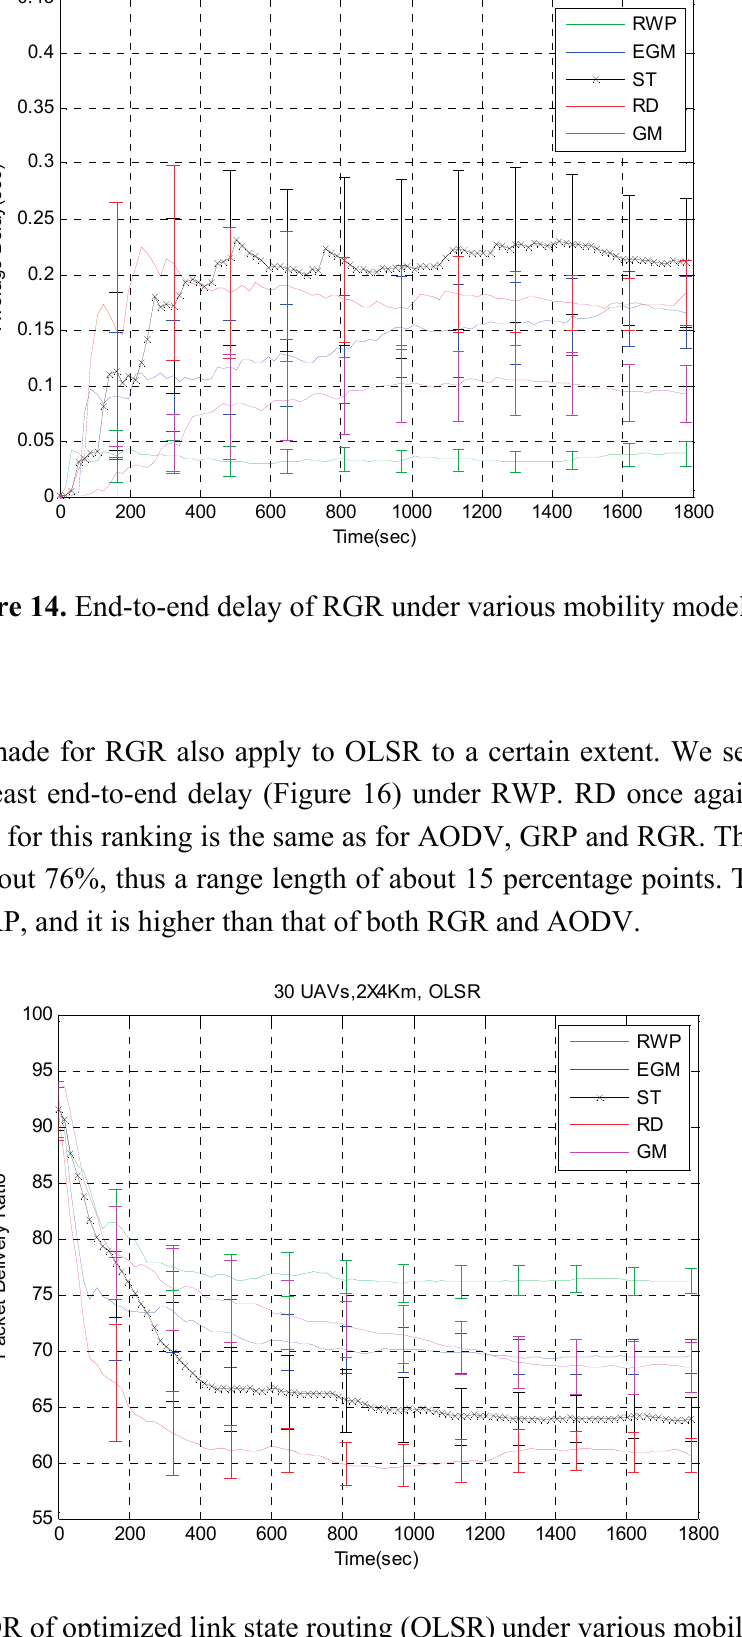
Figure 15. PDR of optimized link state routing (OLSR) under various mobility